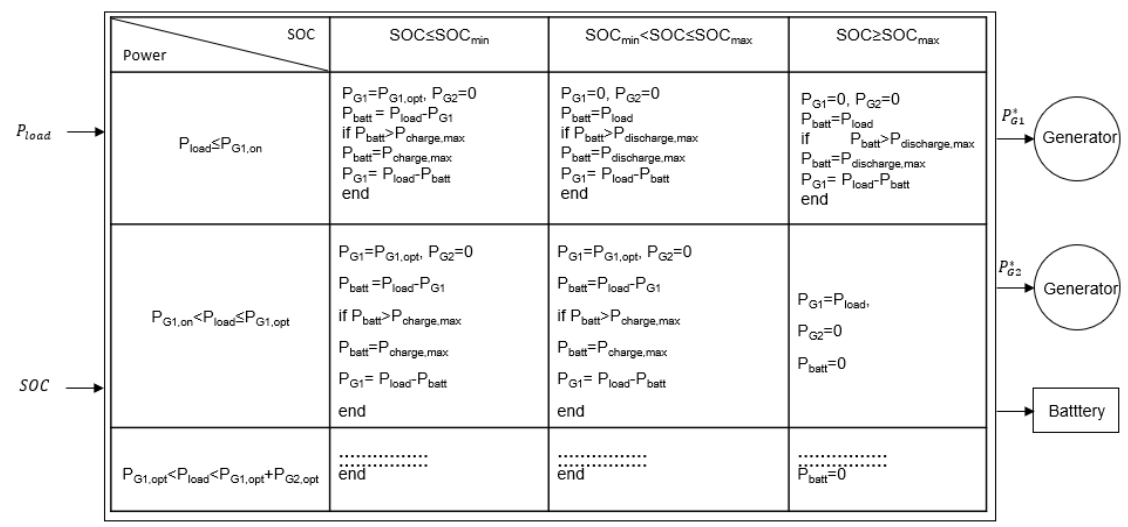
Figure 3. Generator–battery hybrid system with rule-based control employing ECMS.